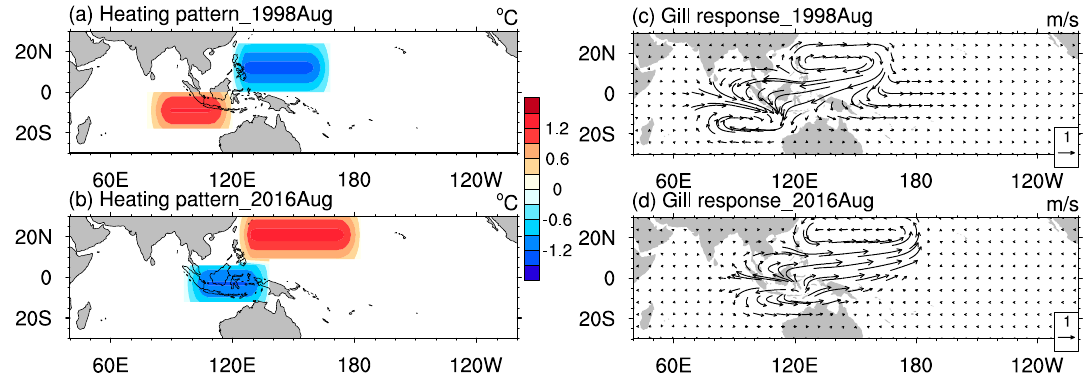
Figure 11. Heating patterns associated with convective latent heating over the western North Pacific (WNP) and Maritime Continent (MC) during August in ( a ) 1998 and ( b ) 2016. ( c )–( d ) Same as in ( a )–( b ) but for the results of the horizontal winds from the Gill model in response to the heating pattern in ( a ) and ( b ).